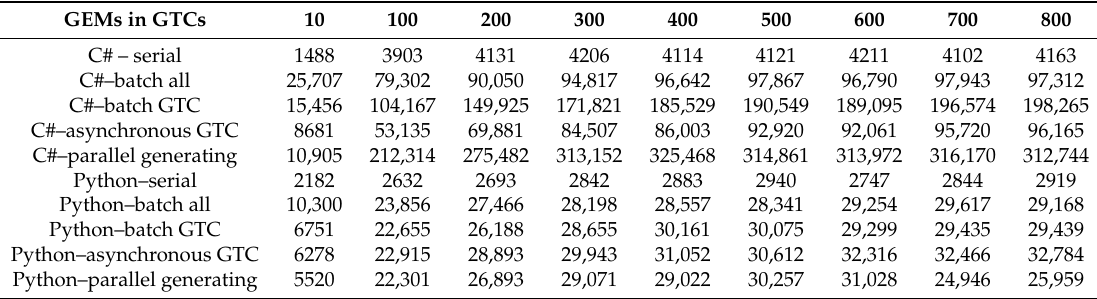
Table 2. Reached results from writing